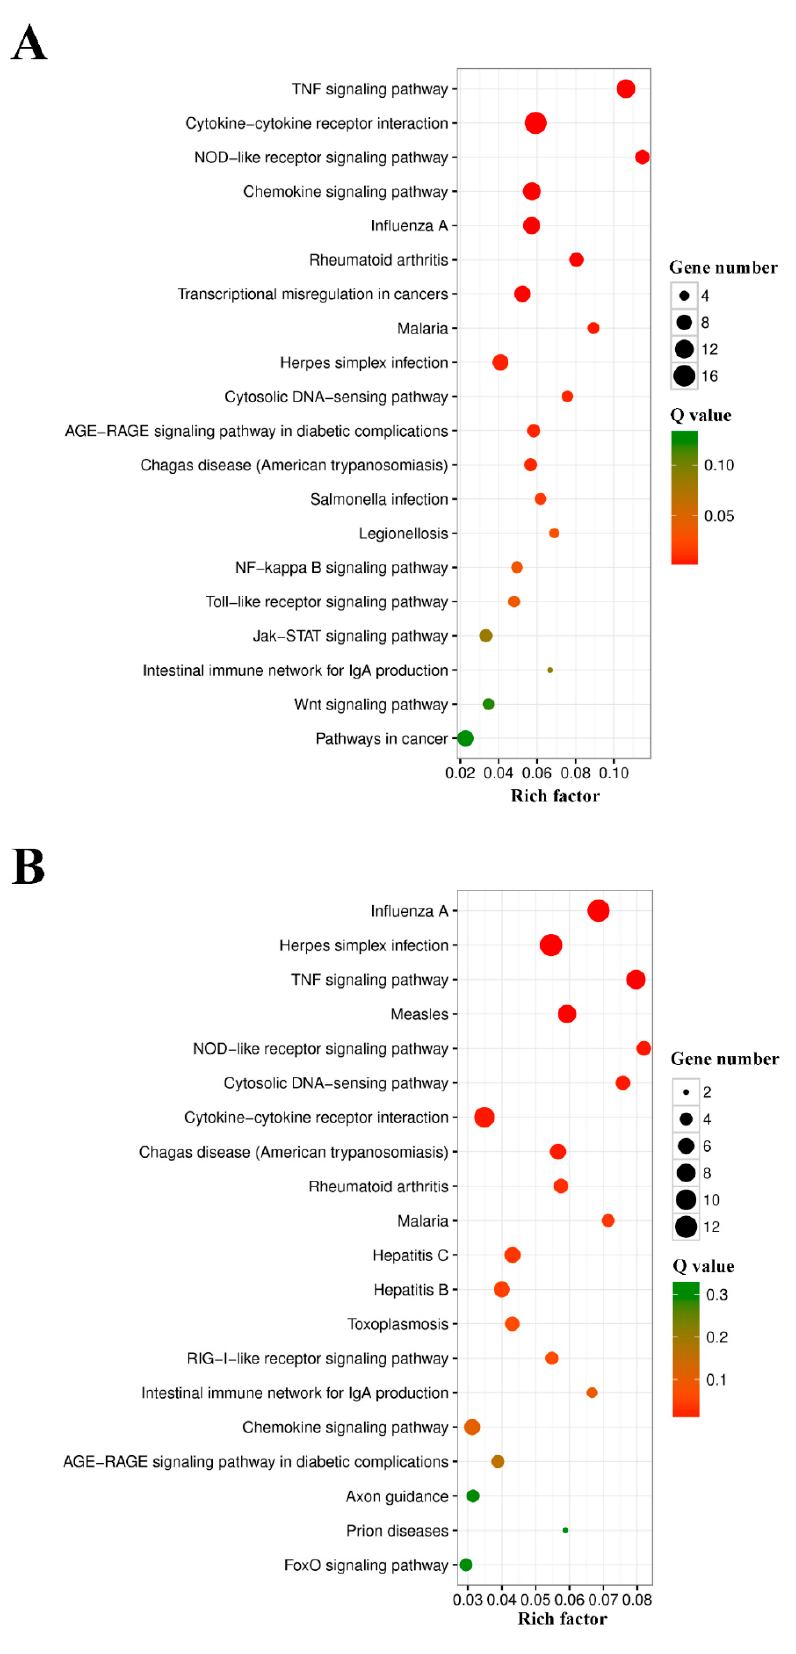
Figure 6. The top 20 enriched KEGG pathways in the differentially expressed genes (DEGs) of L4h-VS-D4h ( A ) and L8h-VS-D8h ( B ). The color and size of the dots indicate Q-values and DEG numbers in pathways, respectively.